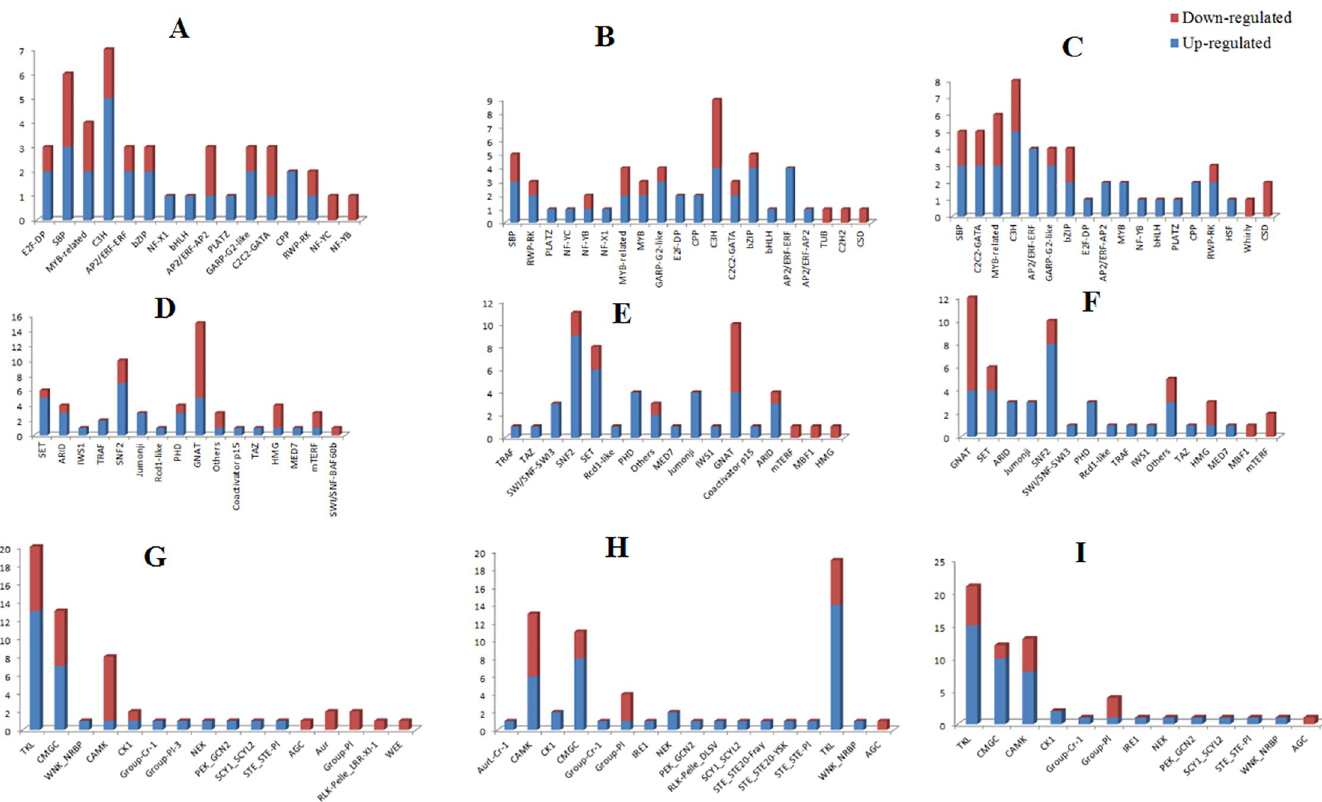
Fig 3. Distribution of TFs, TRs, and PKs families identified in meta genes. The number TF families (A, B and C), TRs families (D, E, and F), PKs families (G, H, and I) in meta genes at LG, TR and PR phases, respectively.